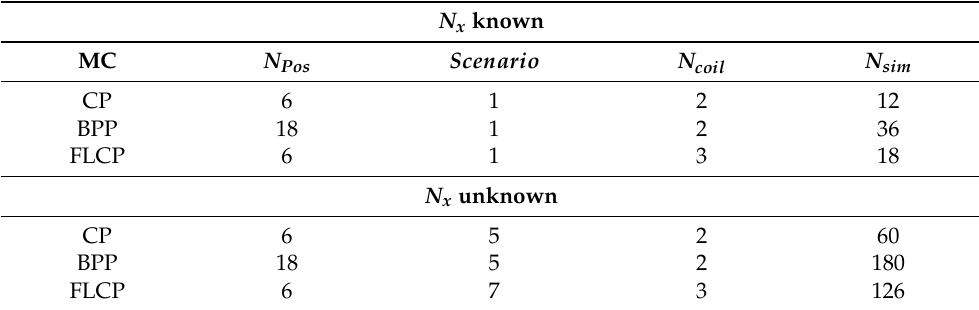
Table 2. Minimum number of required FEA simulations needed to profile the self- and mutual-